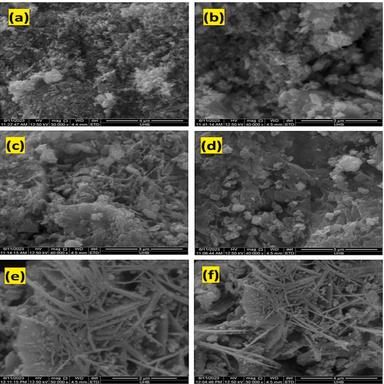
SEM micrographs; (a) CoS, (b) CuCo2O4, and (c) CoS-CuCo2O4 composite.